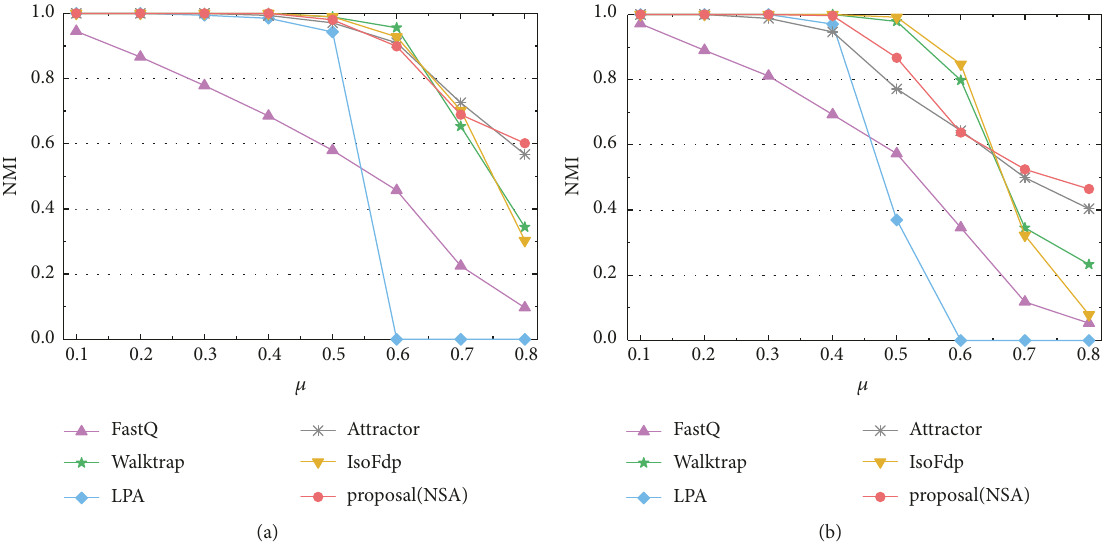
Figure 2: Comparison of different community-detection algorithms on LFR benchmark networks containing 1000nodes . (a) The results detected from small network with small-sized communities. (b) The results identified from small networks with big-sized